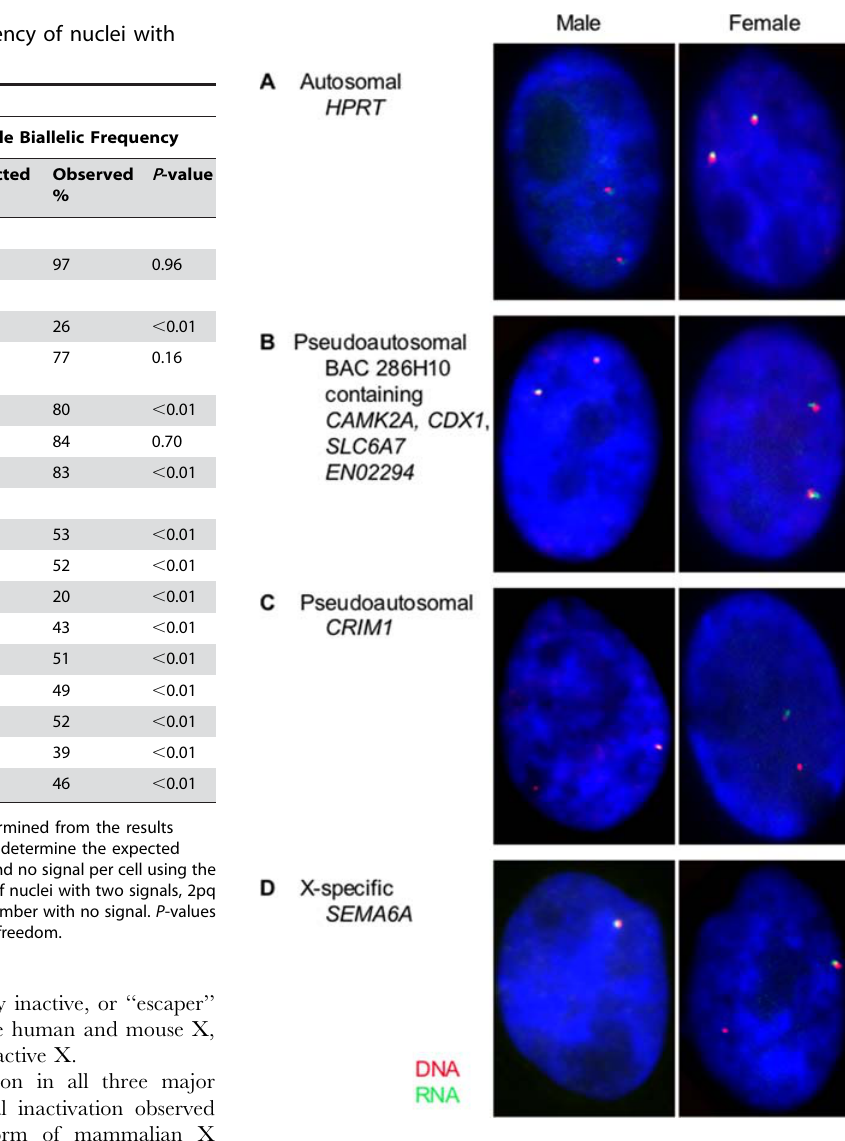
Figure 3. Co-localization of transcripts (RNA - green) and their corresponding gene loci (DNA - red). (A) The autosomal control HPRT1 is expressed from both loci in both sexes since two signals are detected for both RNA and DNA-FISH in both males and females. (B) Pseudoautosomal BAC 286H10 is expressed from both X chromosomes in females and the X and Y in males, since two signals are detected for both RNA and DNA-FISH in males and females. (C) Pseudoautosomal CRIM1 located on X 1 is expressed from only one X in females and only one of the X and Y alleles in males, since two DNA signals but only one RNA signal is detected in both males and females. (D) X-specific SEMA6A located on X 5 is expressed from only one of the two X chromosomes in females, as well as from the single X in males, showing one RNA and DNA signal in males but two DNA signals and only one RNA signal in females.